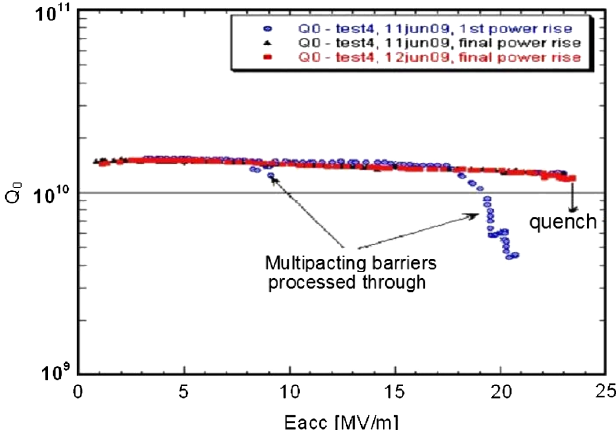
FIG. 8. (Color) Final test result of 3.5-cell large grain cavity after 800 (cid:3) C heat treatment and additional 30 (cid:1) m BCP followed by HPR. Multipacting barriers occurred and were processed during the 1st power rise (blue circle). Gradient reached 23 : 5 MV = m for the final power rise (black triangle and red